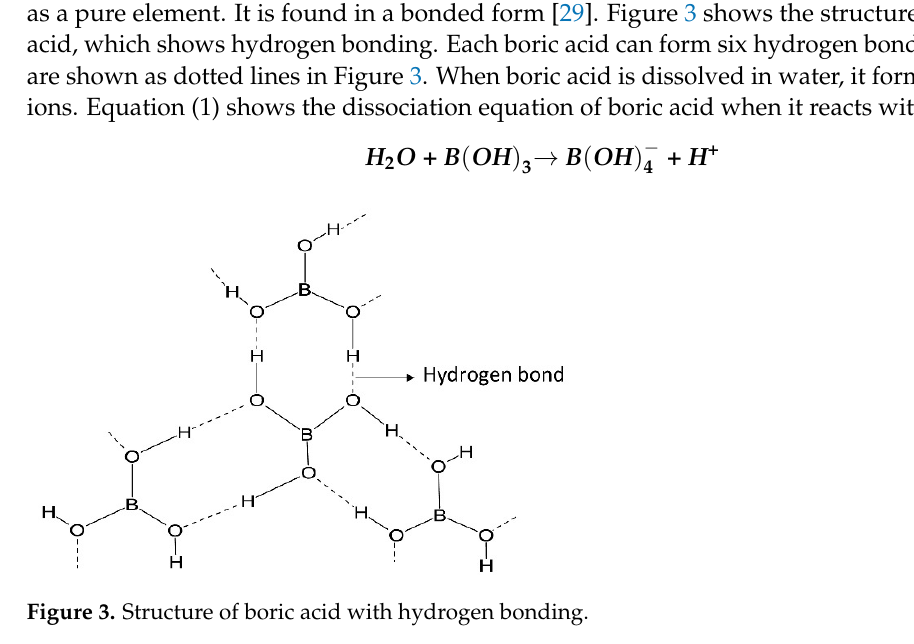
Figure 4. Existence of boron at different pH values. Reprinted with permission from Ref. [32], 2014, Elselvier. 2.2. Sources of Boron Boron enters the environment through natural and human-made processes. The nat- ural weathering of soils and rocks releases boron into the water [33]. Currently, the de- mand for boron has increased due to the active development of modern architecture, which results in the evolution of the electronics, telecommunications (LCD screens), au- tomotive, aviation and energy industries [34]. Boron is widely used in manufacturing fi- berglass, detergents and bleaches [30]. Its highly volatile and soluble nature causes the boron waste from industries to be released into the atmosphere, forming boric acid to be combined in the water resources [35]. Figure 5 shows the origins of boron and the occur- rence of pollution due to the presence of boron. Although nature has its own way of